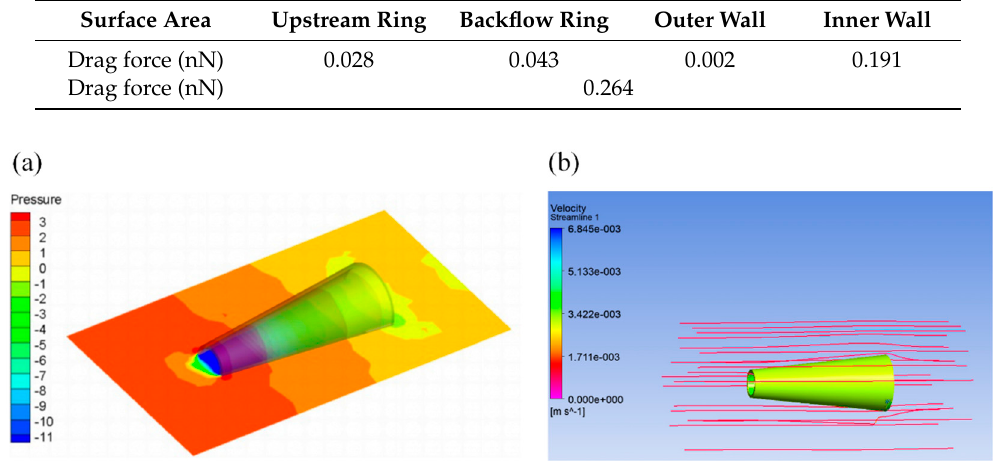
Table 2. Drag forces of the various surfaces of the tubular motor.